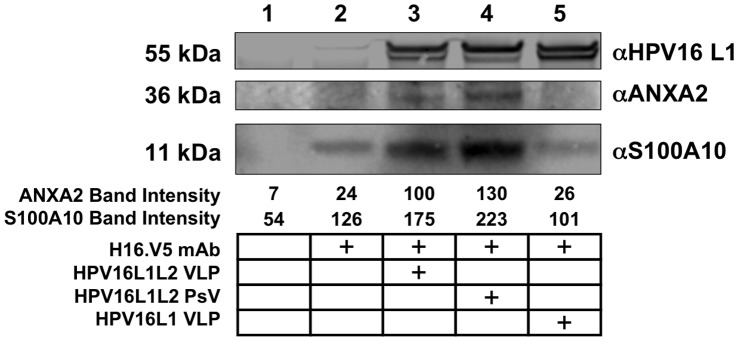
HPV16 binds to A2t on the cell surface of HeLa cells.HeLa cells were incubated with HPV16 L1L2 VLP, HPV16 PsV or HPV16 L1 VLP for 1 hour at 37°C. The cells were washed and surface proteins cross-linked. HPV16 VLP and PsV were precipitated out of cell lysates with an anti-L1 antibody (H16.V5) conjugated to magnetic beads. Elutions were analyzed via Western blot for the presence of ANXA2 and S100A10. Band density was determined by Licor Odyssey imaging software. HPV L1 western blot shows equivalent amounts of HPV16 particles were precipitated in lanes 3–5. The table below the figure indicates which components were included in each treatment. Data are representative of at least three independent experiments.